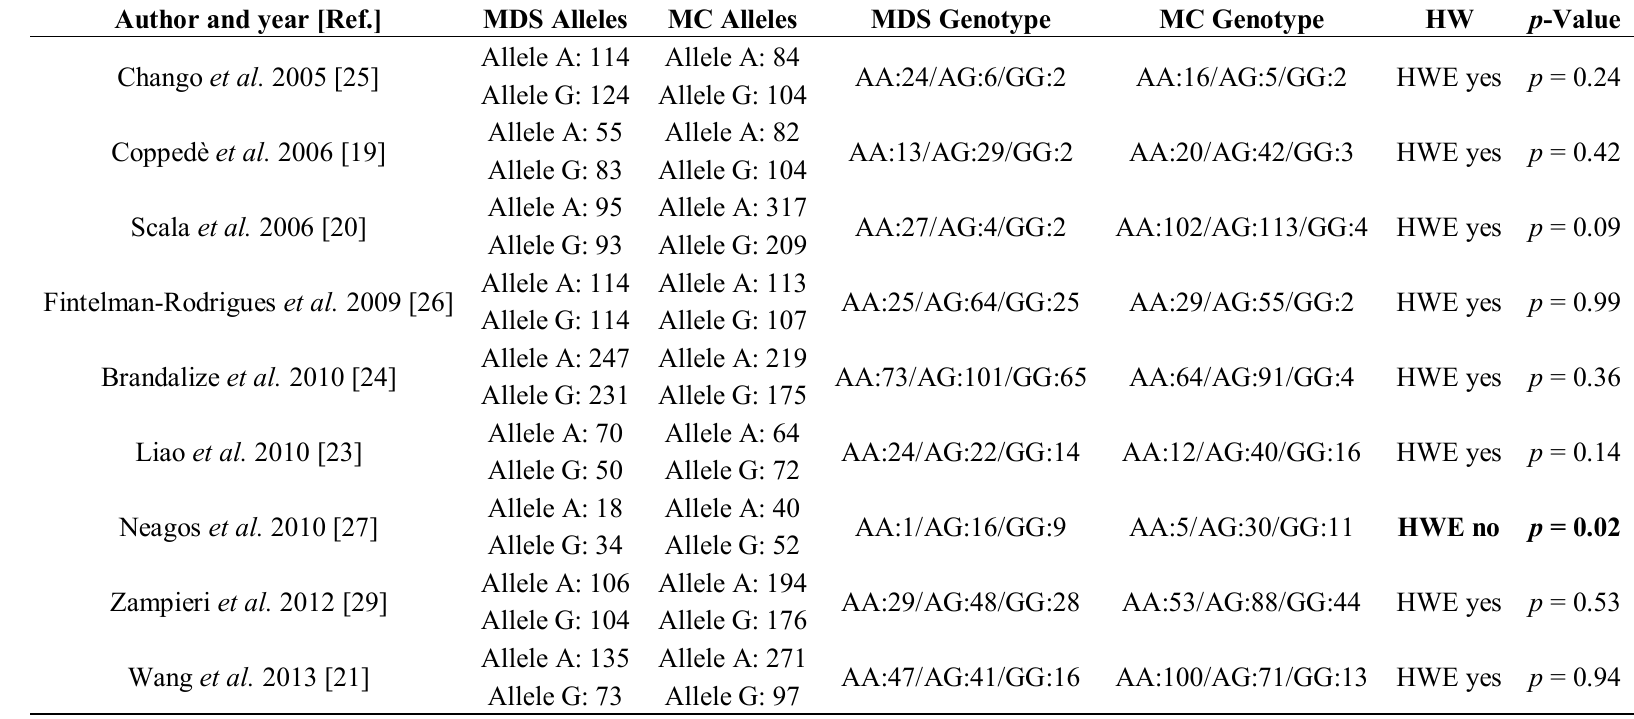
Table 2. Distribution of RFC-1 80A>G alleles and genotypes in Down Syndrome mothers and control mothers. Author and year